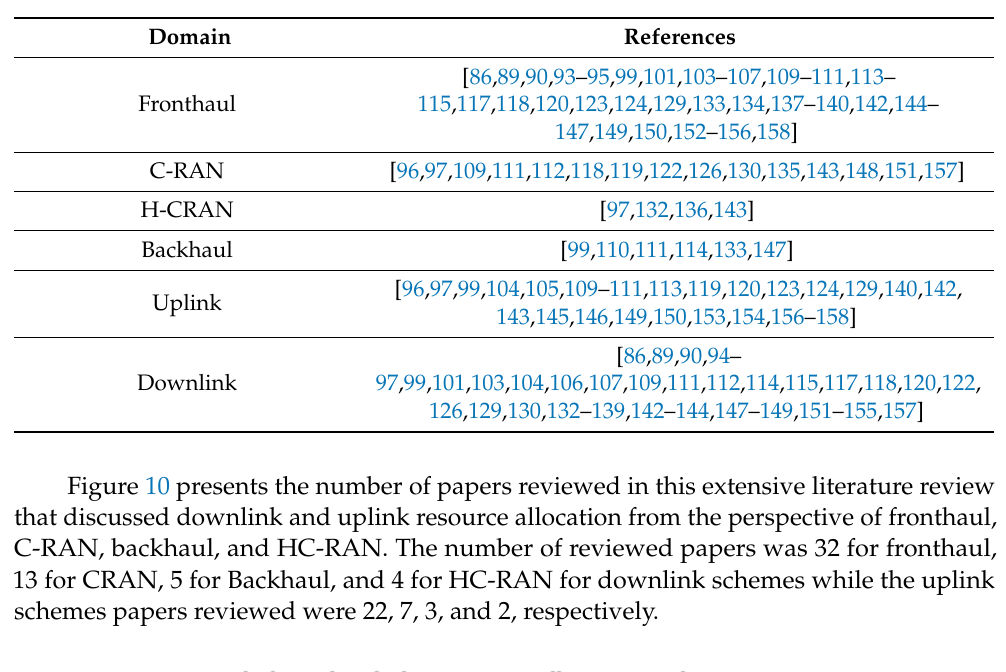
Table 6. Uplink Downlink with Domains.